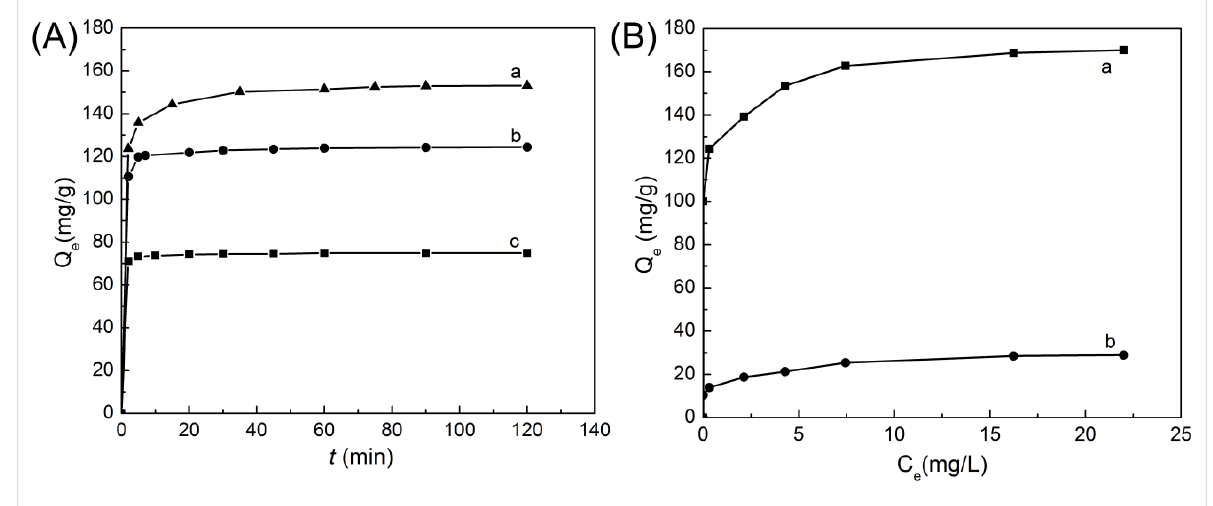
Figure 8: (A) Relationship between the adsorption ability of the hexagonal NPLs-2.5-800 sample and time at different initial RhB concentrations of: (a) 35, (b) 25, and (c) 15 mg/L. The concentration of adsorbents is 0.2 g/L. (B) Adsorption isotherms of the hexagonal NPLs-2.5-800 sample at 25 °C (a) before (with Co nanoparticles) and (b) after (Co nanoparticles removed) HCl etching.